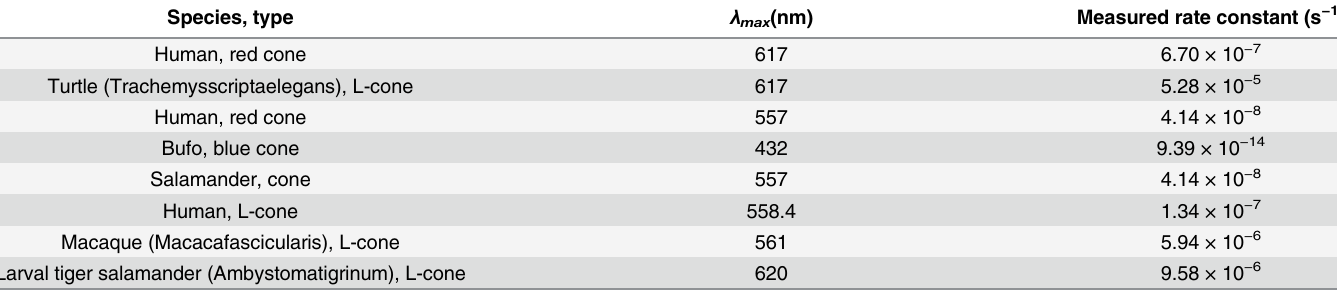
Table 3. Data set II consisting of cone pigments. Data are taken from Luo et al. [2] and Ala-Laurila et al. [9]. Species,